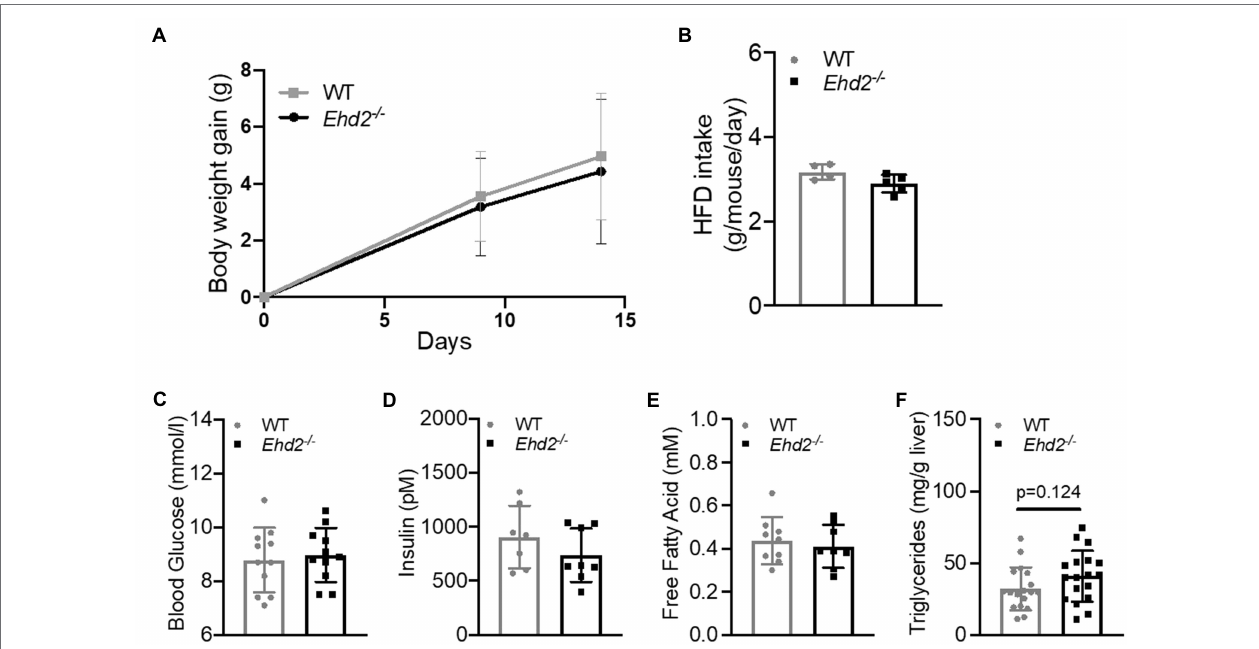
FIGURE 2 | Body weight gain, liver triglycerides, insulin and free fatty acid (FFA) levels in Ehd2 − / − and WT mice following 2 weeks of high-fat diet (HFD)-feeding. WT and Ehd2 − / − mice ( n = 18 animals/group) were subjected to HFD-feeding for 2 weeks, (A) illustrates body weight gain, and (B) food intake